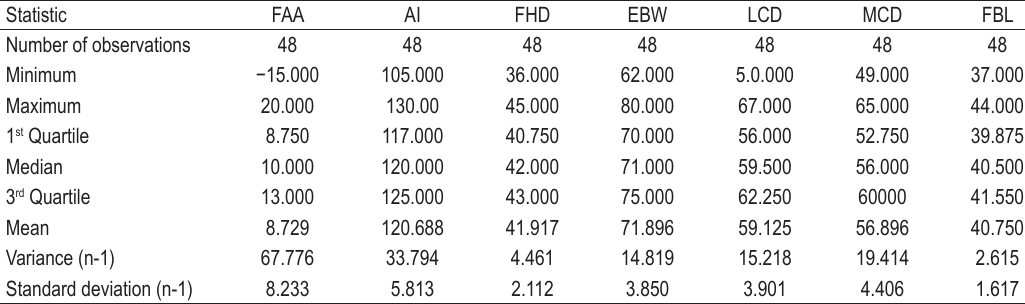
TABLE 2. Descriptive statistics for female samples